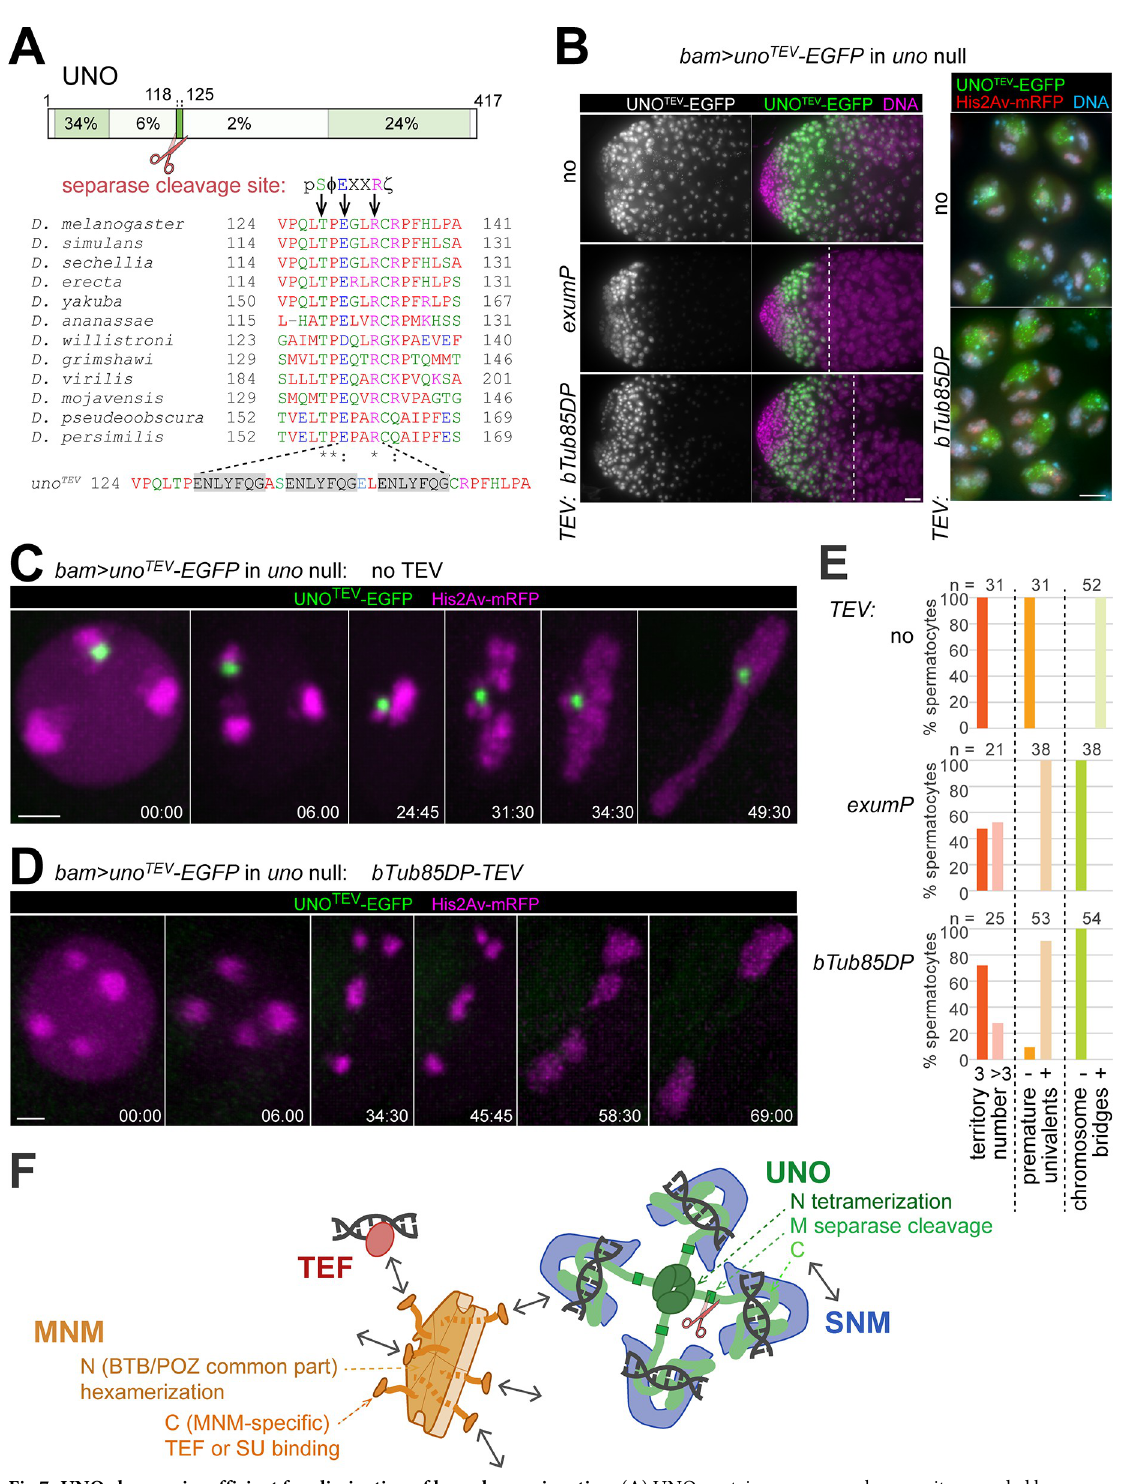
Fig 7. UNO cleavage is sufficient for elimination of homolog conjunction. ( A ) UNO contains a separase cleavage site preceded by a threonine (T128 in D . melanogaster ) that is highly conserved among drosophilids [22], as illustrated with the sequence alignment. Positions essential for UNO cleavage are indicated by arrows. In the consensus sequence of separase cleavage sites [6,49], F indicates hydrophobic, X any amino acid and z hydrophilic residues. Separase cleaves C-terminally after R. The UNO TEV -EGFP mutant contains three repeats of the recognition sequence cleaved by TEV protease (grey shading), replacing the separase cleavage site. ( B ) Squash preparations uno null